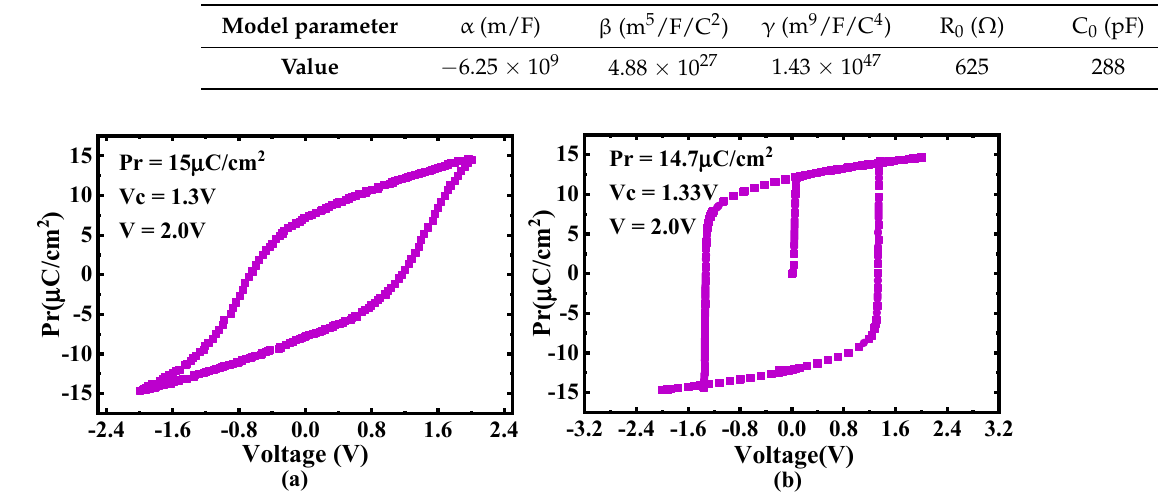
Figure 16. ( a ) Measured and ( b ) simulated P-V curves.